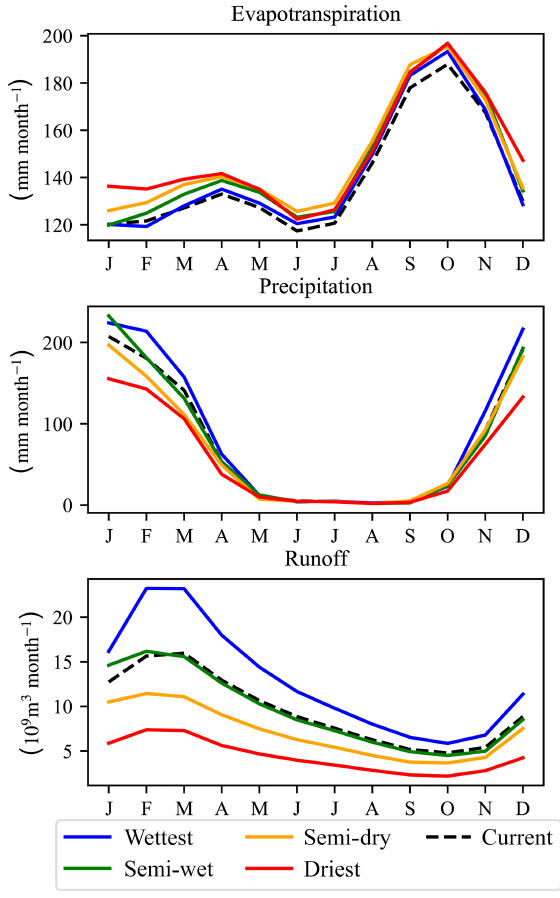
Figure 6. Impact of climate change on hydrologic parameters. The average yearly pattern of evapotranspiration, precipitation, and runoff is shown for the four climate change scenarios and the cur- rent